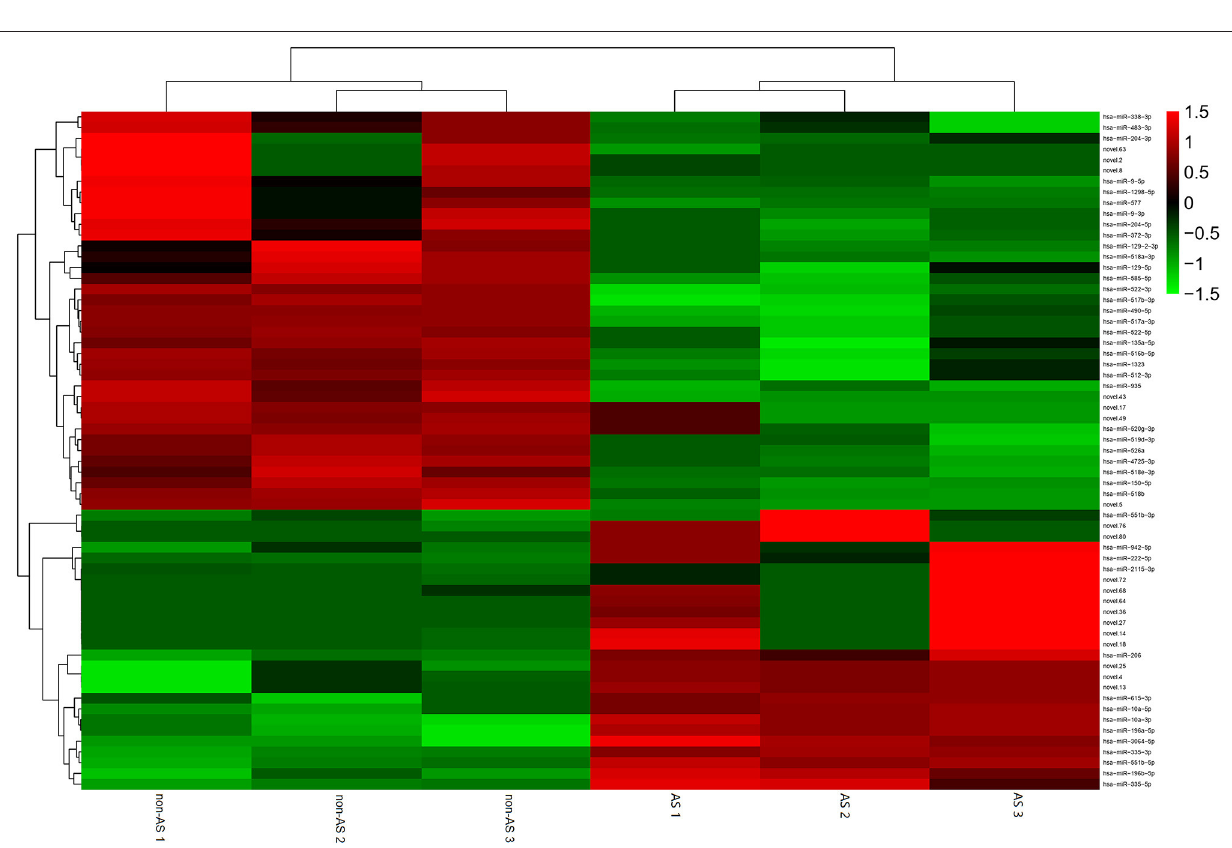
FIGURE 5 | Heatmap of differential miRNAs in EAT-derived exosomes. non-AS: EAT-derived exosomes of non-CAHD patients. AS: EAT-derived exosomes of CAHD